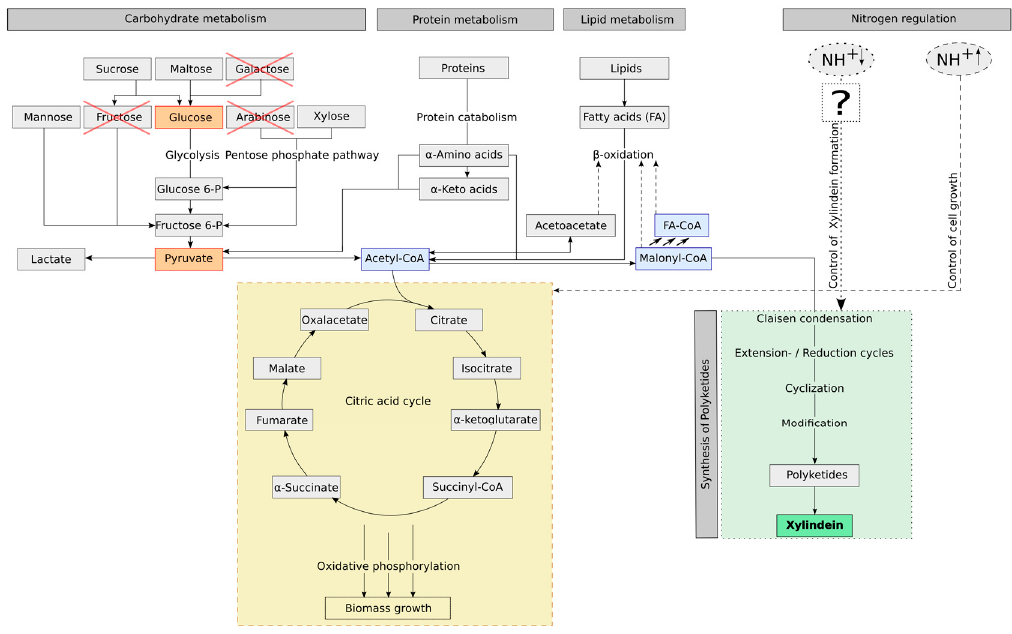
Figure 3. Schematic survey of the influence of various substrate ingredients on the potentially metabolic pathway of Chlorociboria aeruginascens. Legend: dotted line—regulation of xylindein formation (green box); dashed line—regulation of biomass growth (yellow box); cross symbol—not metabolized by C.